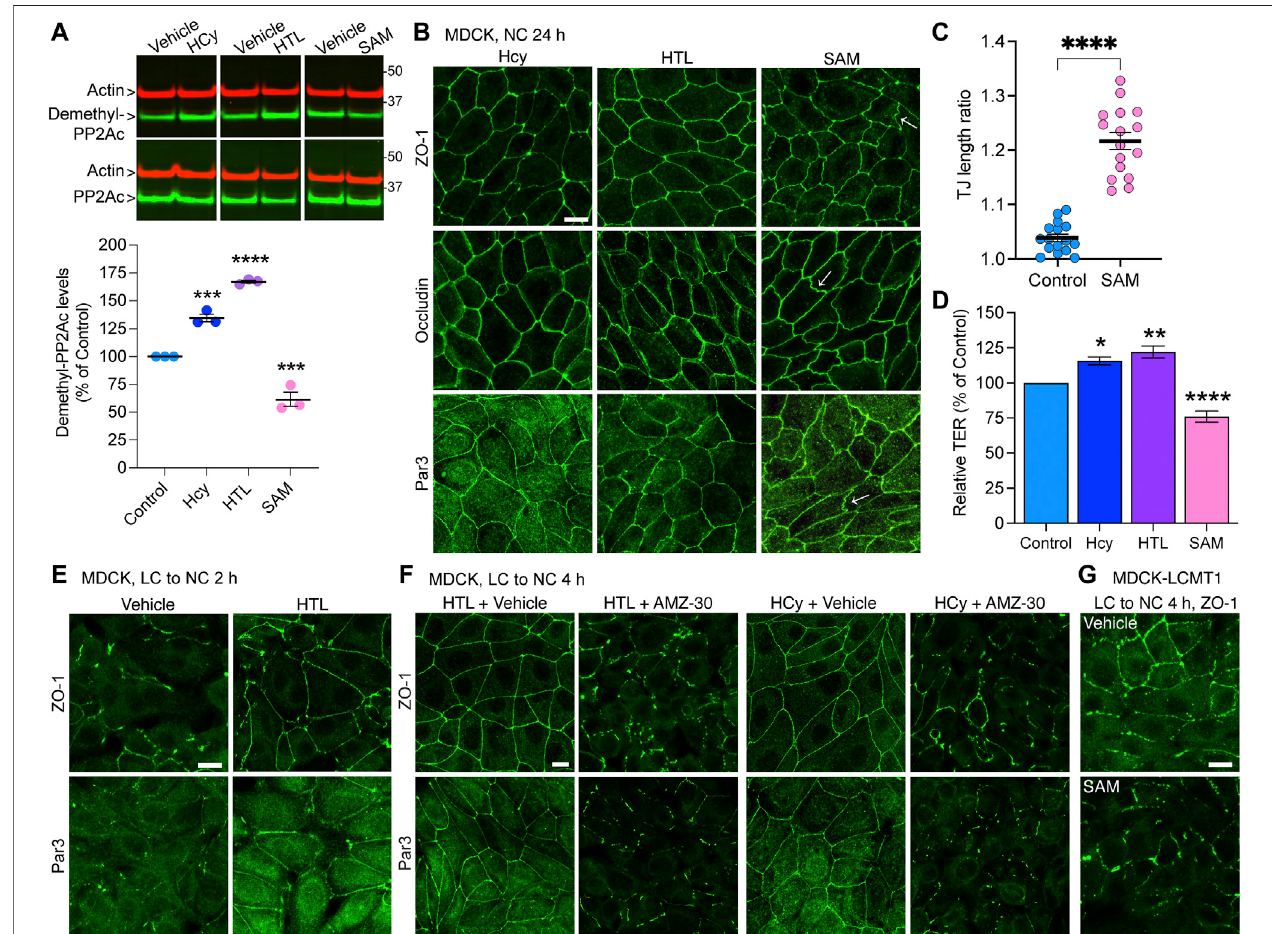
FIGURE5| Hcy,HTLandSAMmetabolitesmodulatePP2AmethylationstateandTJassembly. (A) TotalanddemethylatedPP2AcwereanalyzedbyWesternblot (top) in total lysates from MDCK cells incubated for 24 h in NC medium in the presence of either 100 μ M Hcy, 100 μ M HTL, 100 μ M SAM, or vehicle. Demethylated PP2Ac levels were quanti fi ed in these cells (bottom). Data (mean ± SEM; n = 3) were appraised using one-way ANOVA (F = 150.6; p < 0.0001) with post hoc Dunnett ’ s test.**** p < 0.0001,*** p < 0.001,versusvehicle-treatedcontrols. (B) DistributionofZO-1,occludinandPar3inthesecells.Arrowsindicateexamplesofruf fl edTJs. (C) Quanti fi cationofTJruf fl inginSAM-treatedMDCKcells(mean±SEM;Student ’ s t -test;**** p < 0.0001). (D) TERvaluesweremeasuredincellsfrom (B) .Data(mean± SEM; n = 6 Transwells) were analyzed using one-way ANOVA (F = 42.12; p < 0.0001) with post hoc Dunnett ’ s multiple comparisons test. **** p < 0.0001, *** p = 0.001, * p < 0.05, versus vehicle-treated control cells. (E) Distribution of ZO-1 and Par3 in MDCK cells switched for 2 h from LC to NC medium in the presence of either 200 μ M HTLorvehicle. (F) DistributionofZO-1andPar3inMDCKcellsswitchedfor4 hfromLCtoNCmediumcontainingeither200 μ MHcyorHTL,togetherwith20 μ MAMZ- 30 or vehicle. (G) Distribution of ZO-1 in MDCK-LCMT1 cells switched for 4 h from LC to NC medium in the presence of either 200 μ M SAM or vehicle. For (B,E – G) , representative confocal images are shown; similar results were obtained in three separate experiments. Scale bars = 10 μ m.